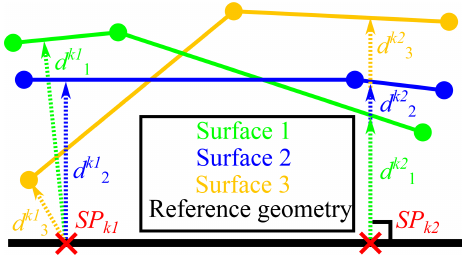
Figure 1. Visualization of different sampling strategies: shortest distance (left) and normal vector